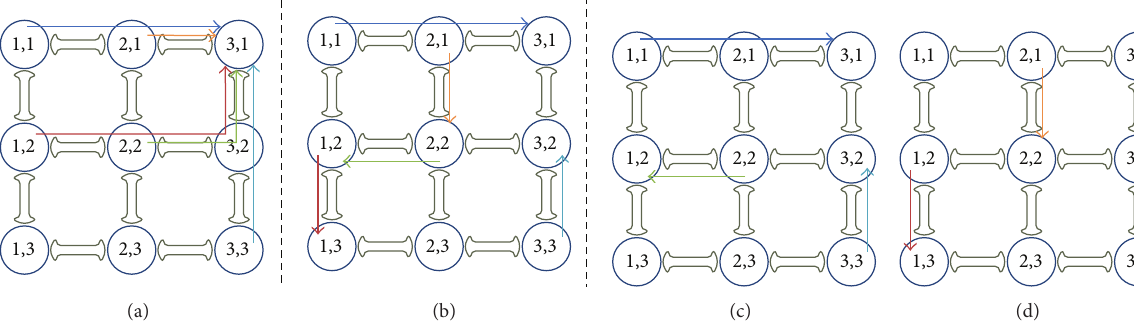
Figure 5: Examples of communications in a 3 × 3 2D-mesh